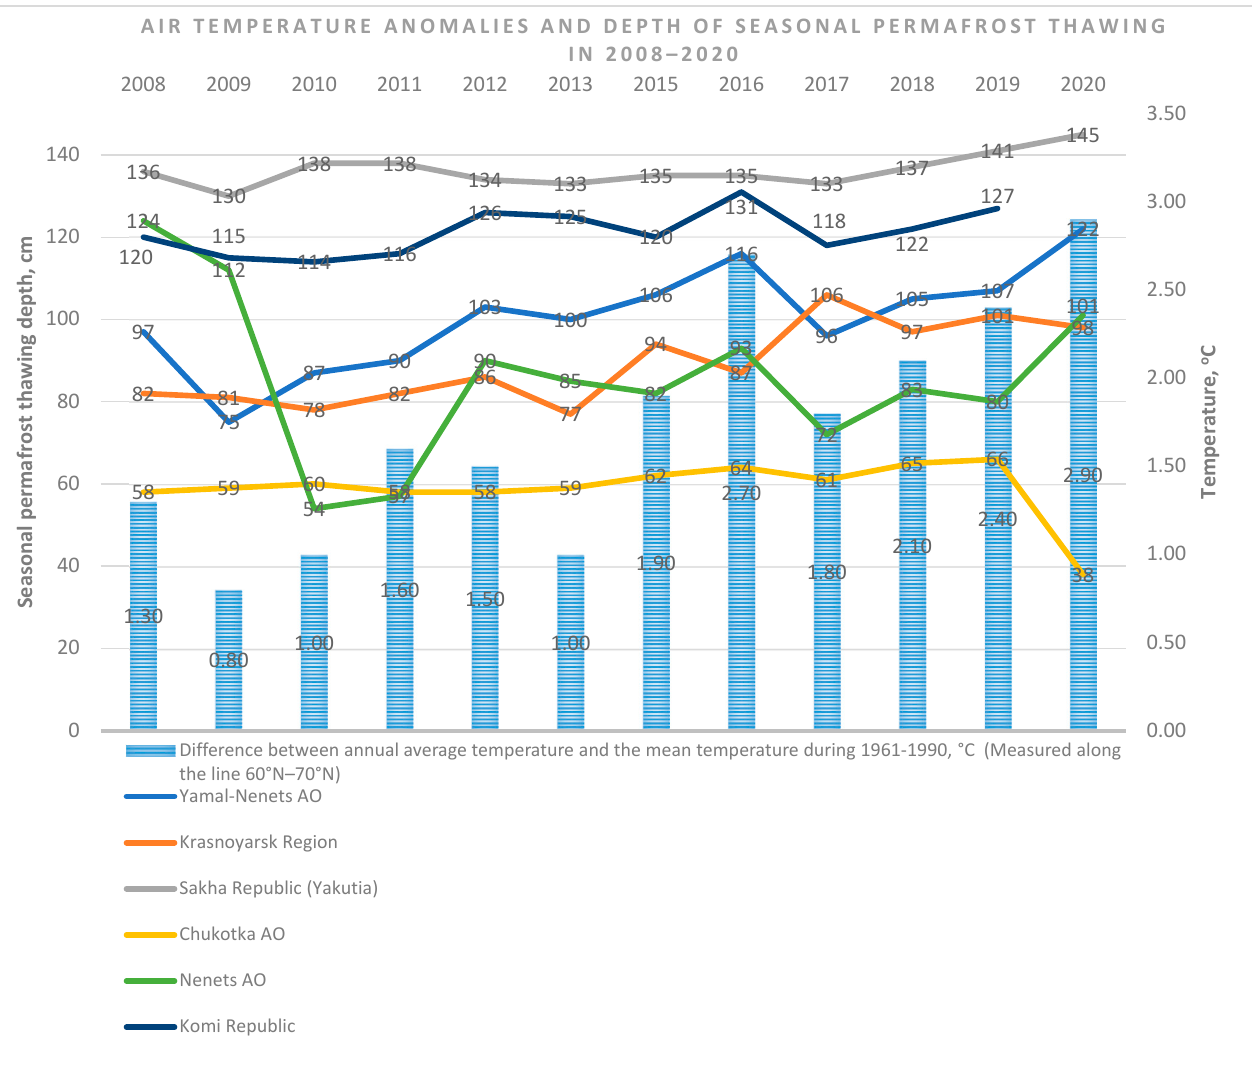
Figure 1. Air temperature anomalies and depth of seasonal permafrost thawing in 2008–2020. Seasonal thawing depths were averaged by region based on the data reported by the Circumpolar Active Layer Monitoring (CALM) program. Available online: https://www2.gwu.edu/~calm/data/north.htm (accessed on 26 March 2022). Incomplete time series from several monitoring stations were excluded. AO—Autonomous Oblast (Region). Source: Authors’ calculations.